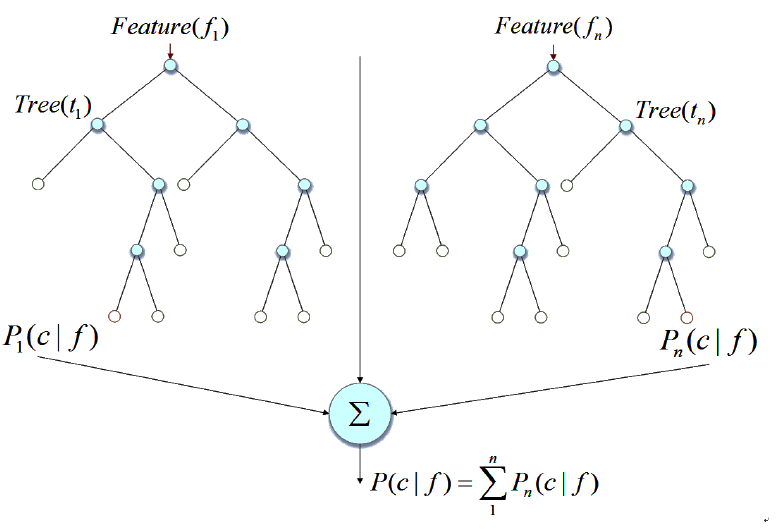
Figure 1. Schematic diagram of extreme random tree